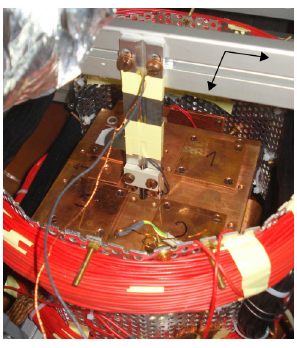
FIG. 2. Setup to scan trapped flux in Nb samples.